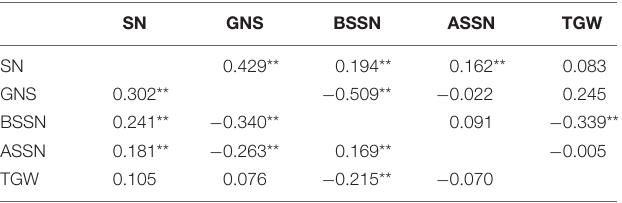
TABLE 2 | Correlation analysis of different traits for 282 common wheat accessions under the I1 and I3 treatments.